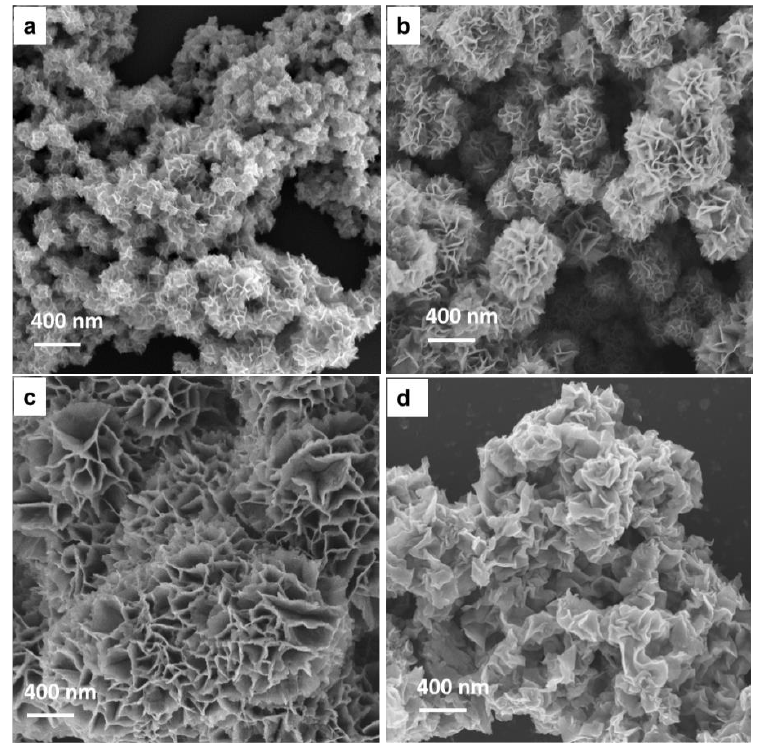
Figure 1. SEM images of the ( a ) W 2 C / WS 2 _2h, ( b ) W 2 C / WS 2 _4h, ( c ) W 2 C / WS 2 _12h, and ( d ) WS 2 NFs. 112